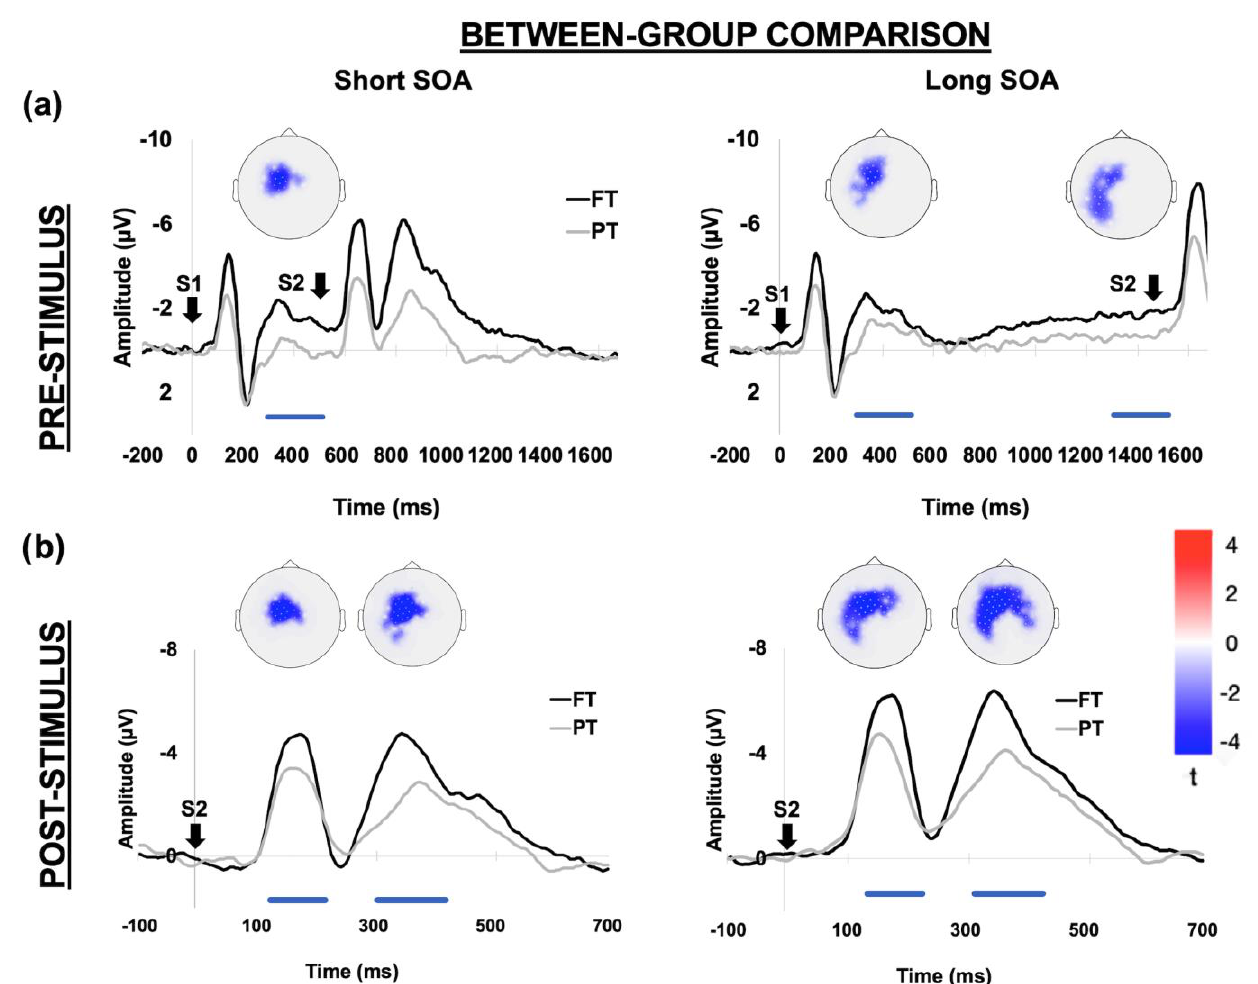
Figure 4. Between-group ERP comparison. The upper panel ( a ) represents the statistically significant electrodes exceeding the critical t-score threshold for statistical significance over the pre-stimulus window (stimulus expectancy/response preparation). The negative cluster indicates that ERP mean amplitude is significantly larger (i.e., more negative) in the FT than in the PT group for both short and long SOA intervals over left-central electrodes. These effects extended over a 300 ms window before S2 onset, including a N2/CNV modulation for the short SOA condition and a CNV modulation for the long SOA condition. The ERP waveforms below the scalp maps show the time series derived by averaging the electrodes included in the negative cluster. The S1 at 0 ms indicates the ERP time locking, while S2 indicates the onset of the imperative stimulus. The lower panel ( b ) represents the same analysis performed over the post-stimulus window (stimulus processing/response implementation). The negative cluster indicates that ERP mean amplitude is significantly larger (i.e., more negative) in the FT than in the PT group for both short and long SOA intervals over left-central electrodes in two distinct windows, covering the N1 and N2 temporal range. The ERP waveforms below the scalp maps show the time series derived by averaging the electrodes included in the negative cluster. The S2 at 0 ms indicates the ERP time locking. For all comparisons the colored horizontal bars represent the timing of significant ERP